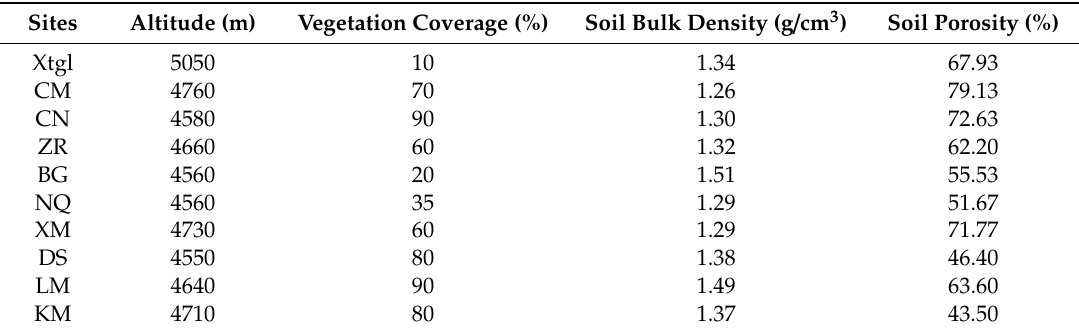
Table 1. Site information and soil property